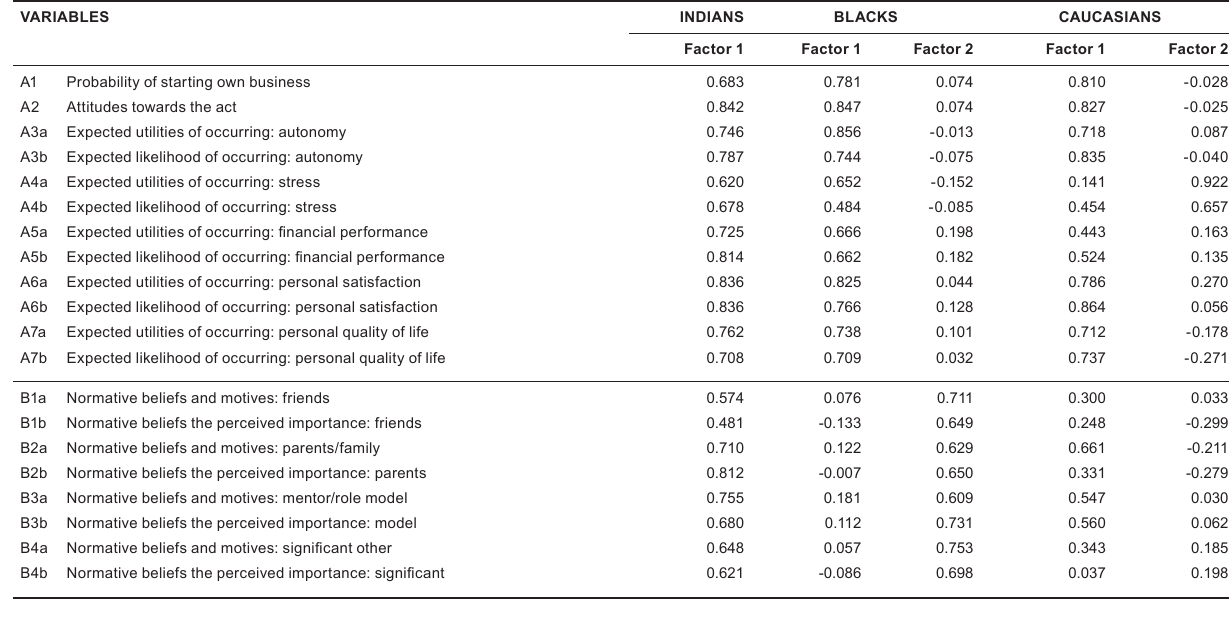
Table 1 Final factor categorisations and loadings for attitudes, beliefs and